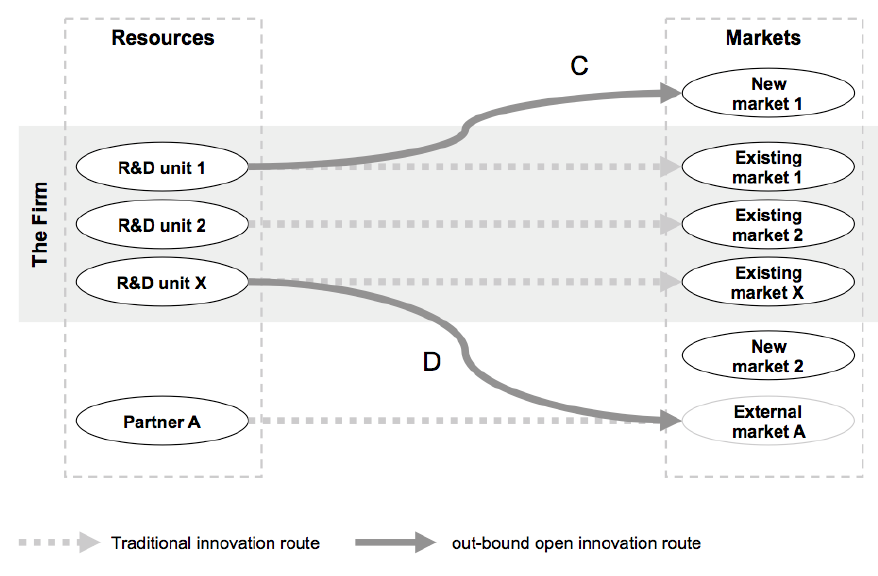
Fig. 3. Out-bound open innovation (Mortara et al., 2011, p.